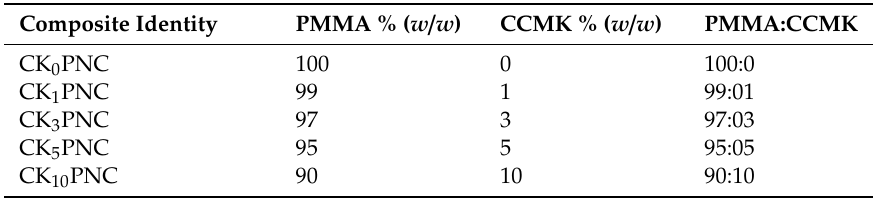
Table 1. Compositional variation of nanocomposite films produced from poly(methylmethacrylate) (PMMA) and chloride modified kaolinite